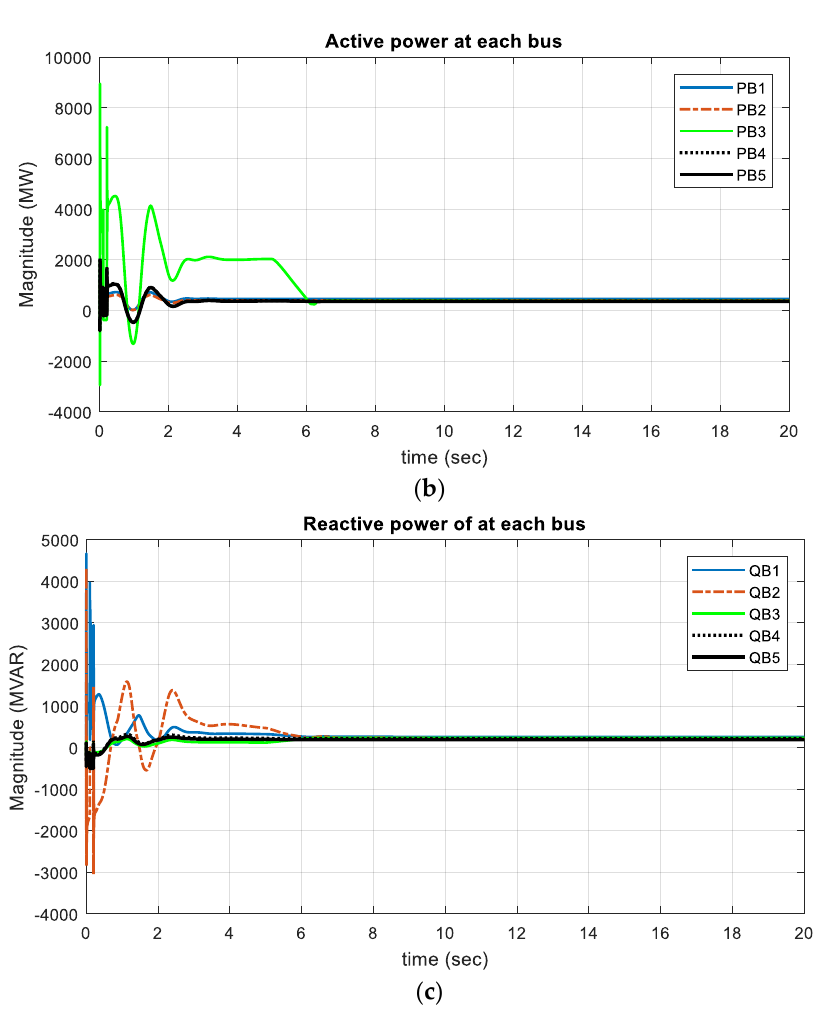
Figure 9. Simulation results of positive sequence voltage ( a ), active ( b ) and reactive power ( c ) with ALO.